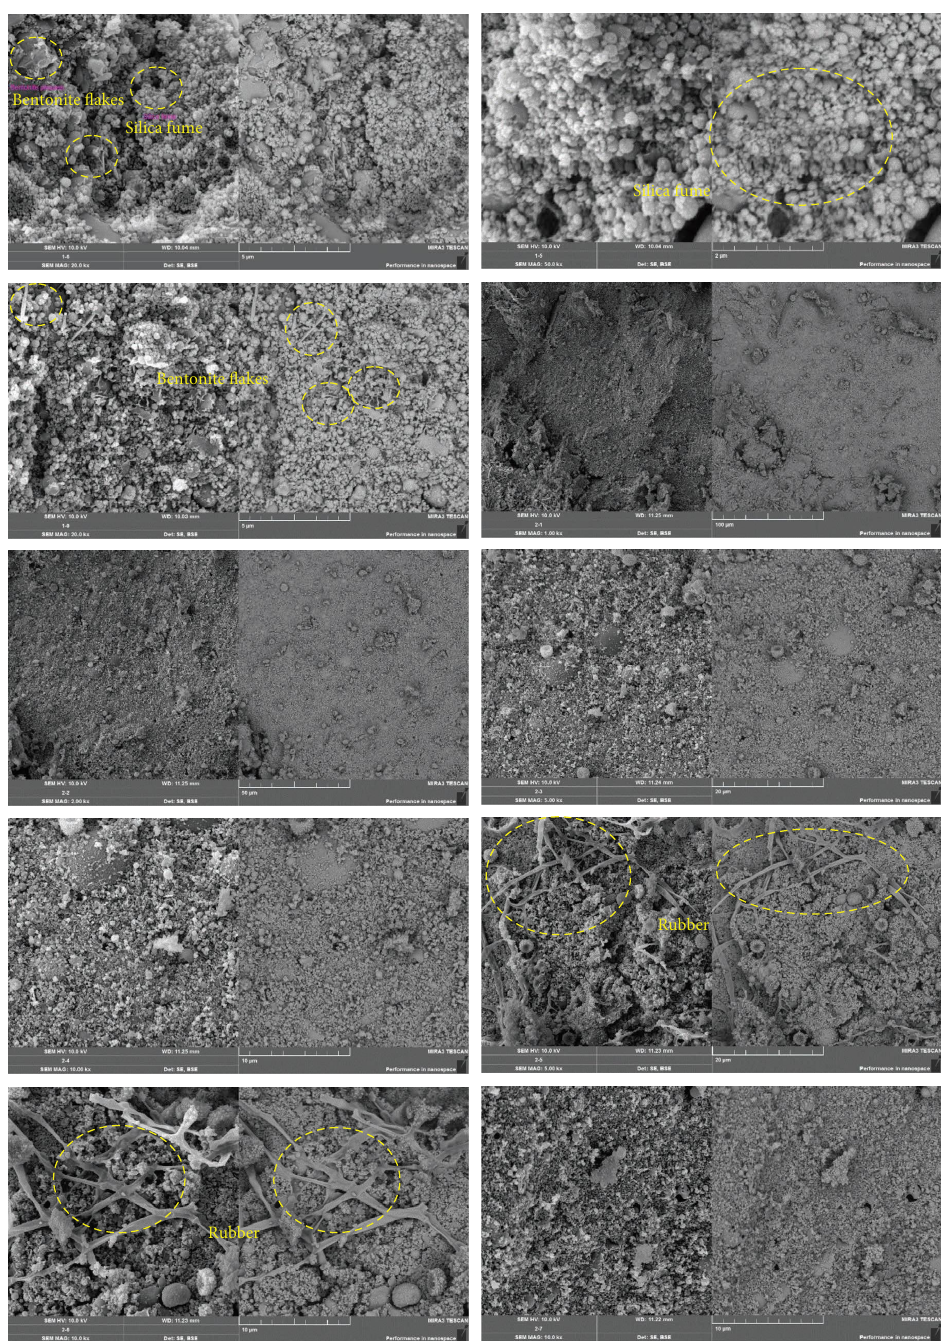
Figure 11: Microstructural analysis of samples with and without rubber added using